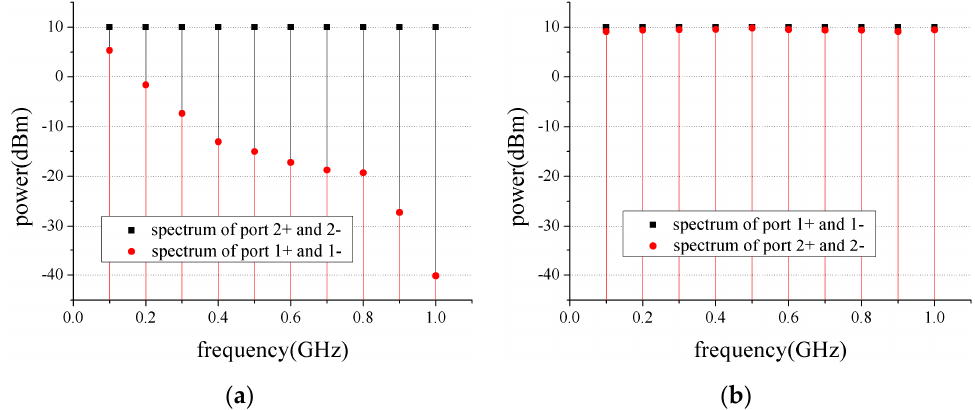
Figure 6. Schematic of the Wilkinson power splitters (combiners).